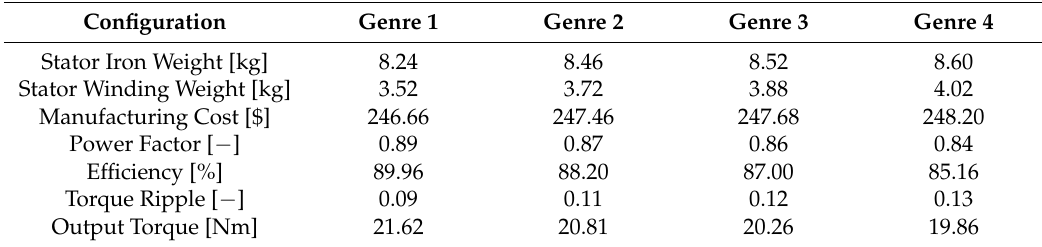
Table 6. Comparative results of machine performance for four kinds of